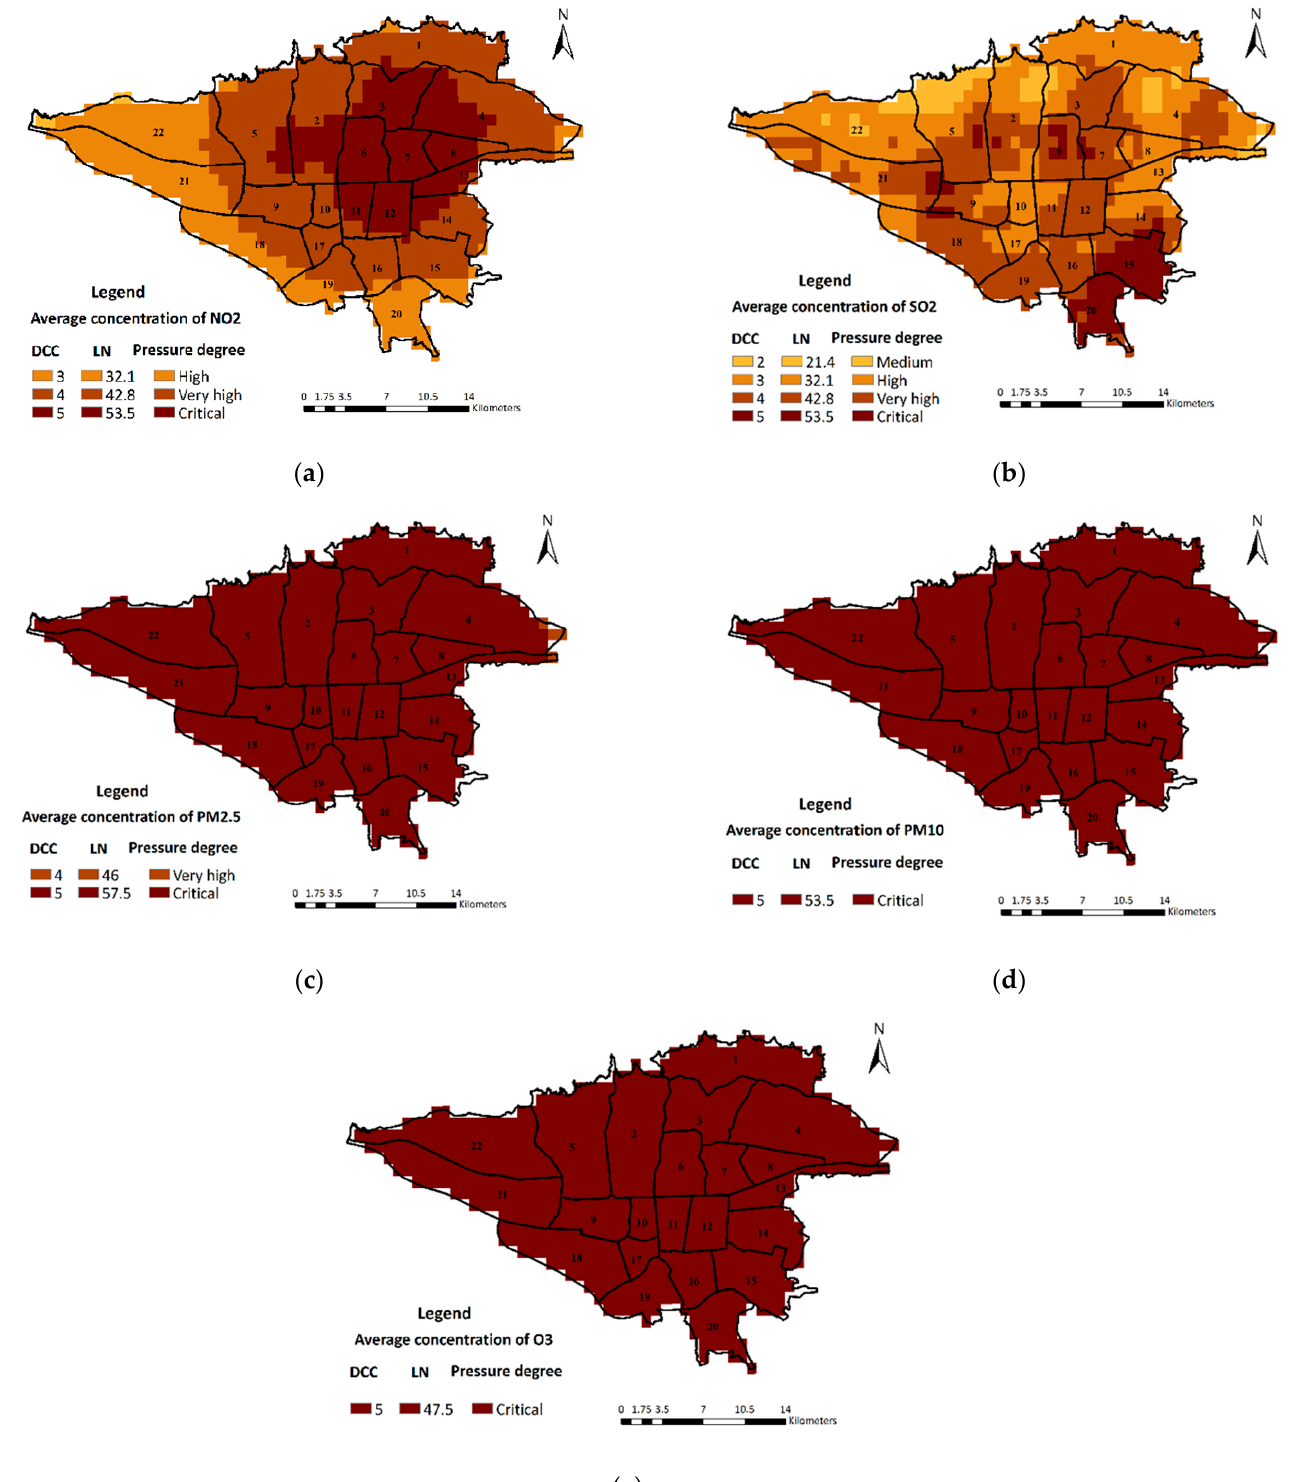
Figure 4. The DCC and LN maps of air indicators. ( a ) NO 2 ; ( b ) SO 2 ; ( c ) PM 2 . 5 ; ( d ) PM 10 ; ( e ) O 3 .